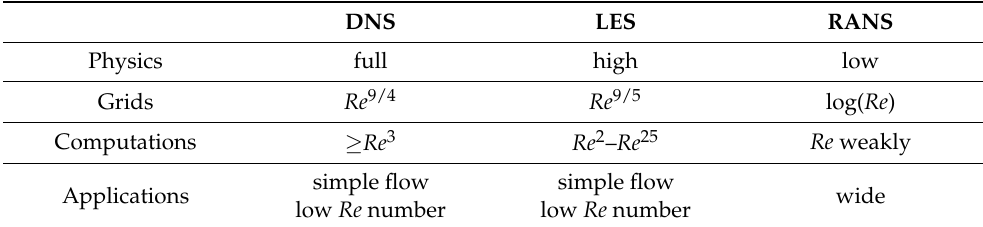
Table 1. Comparison of DNS, LES, and